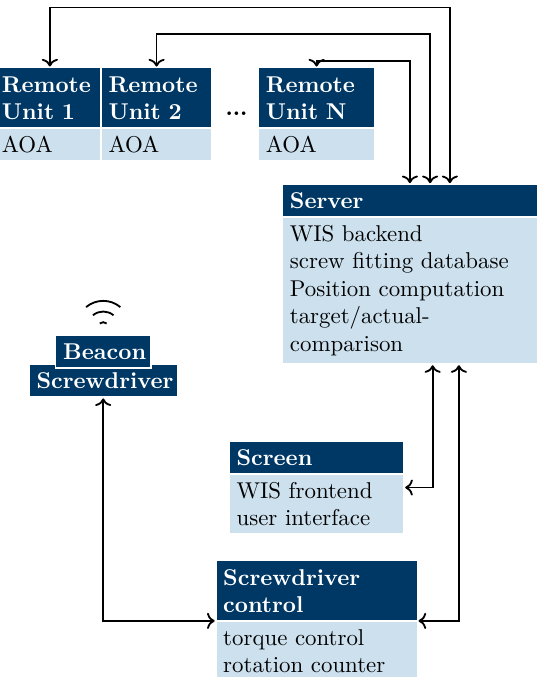
Figure 2. Block diagram of the system components, their tasks, and the communication